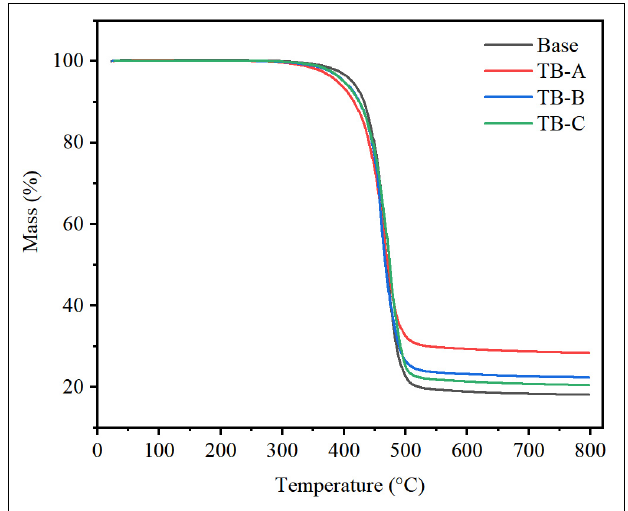
FIGURE 11 | TG curves for TB-A